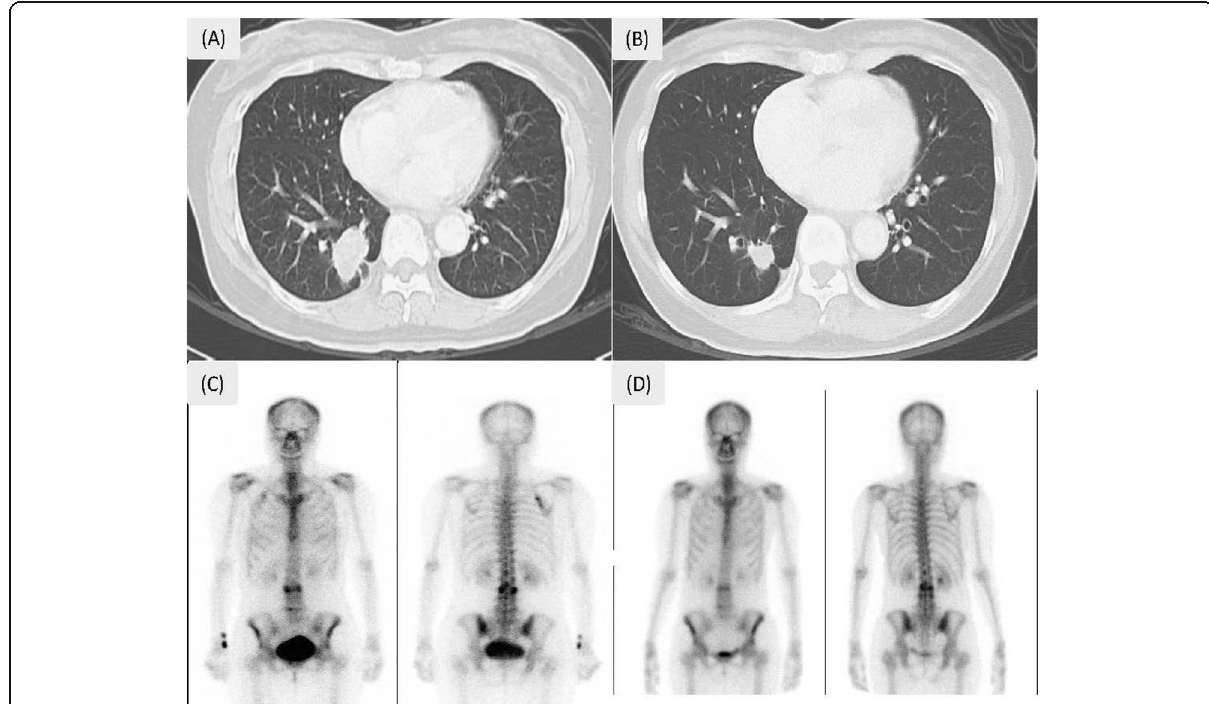
Fig. 1 Patient scans. a Chest computed tomography scan: pre-tyrosine kinase inhibitors (TKI) therapy in March 2017. b Post-TKI therapy and pre- surgery in November 2018; right lower lobe lung mass regressed but noticeable. c Whole body bone scan: pre-TKI in March 2017. d During